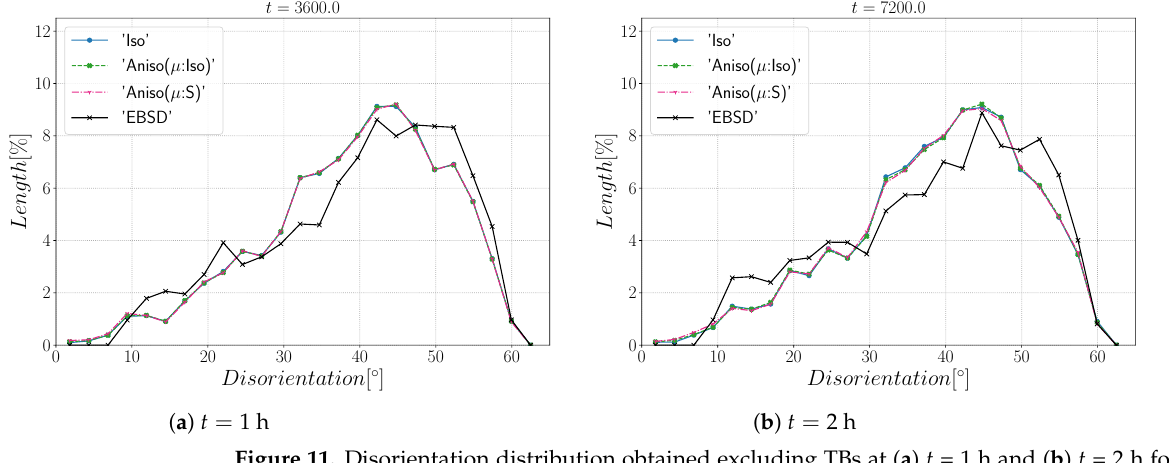
Figure 10. Grain size distributions obtained excluding TBs at ( a ) t = 1 h and ( b ) t = 2 h for the isotropic (Iso) formulation, anisotropic formulations with isotropic GB mobility (Aniso( µ :Iso)) and heterogeneous GB mobility (Aniso( µ :S)) and the experimental data (EBSD). N G refers to the number.